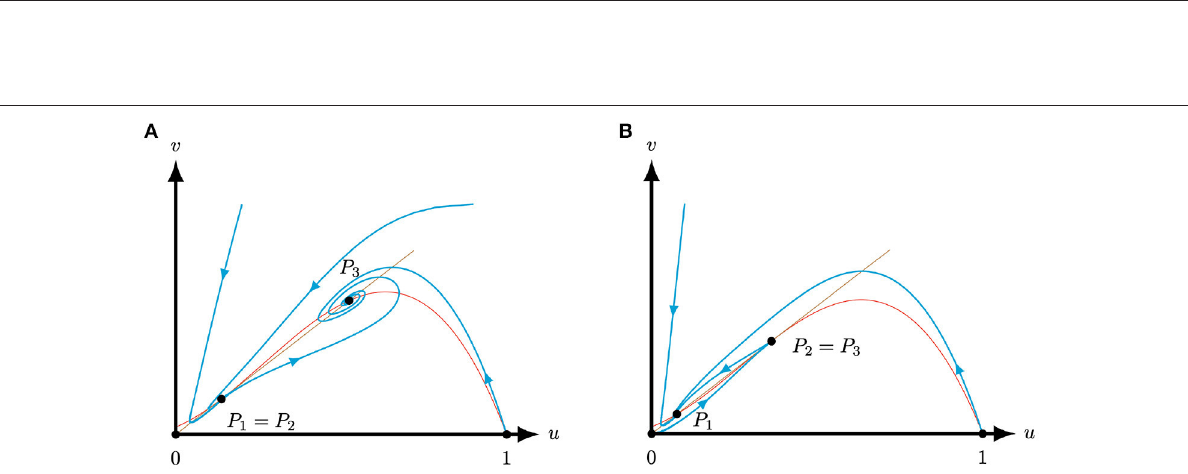
FIGURE 4 | Phase planes of system (4) for A equilibria (0,0), (1,0) and P 2 are always saddles. The brown (red) curve represents the predator (prey) nullcline. (A) For S S 0.2 the equilibria P 1 is an attractor and P 3 is a repeller. (C) For S =